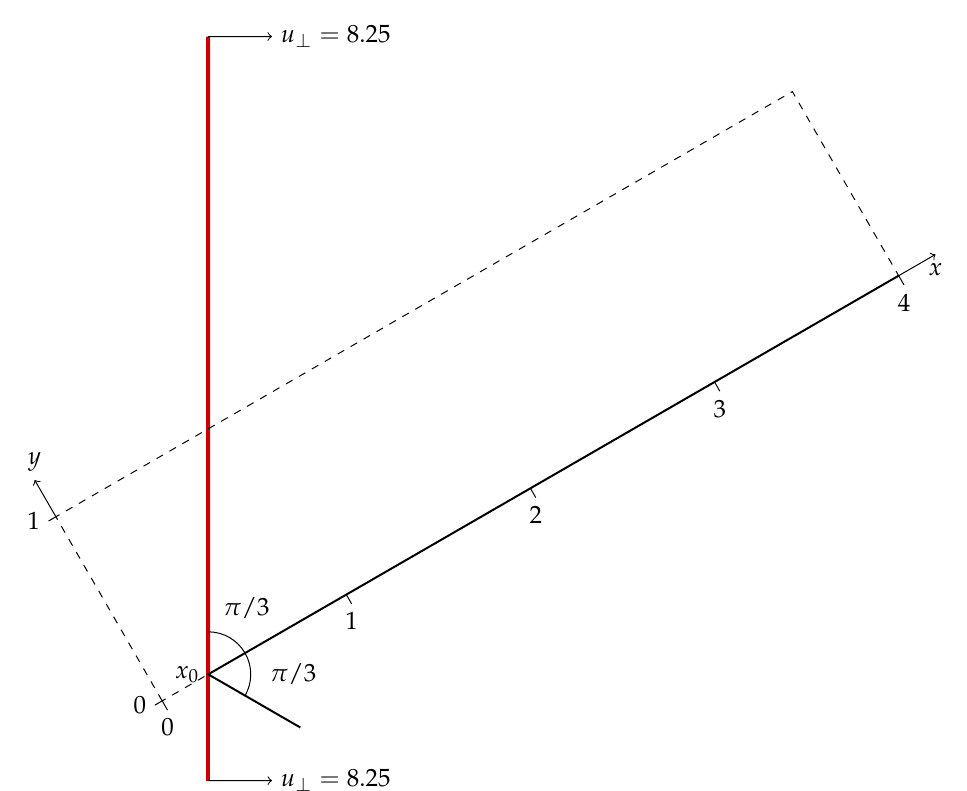
Figure 19. A schematic diagram of Problem 6. The rectangle bounded by four dashed lines and a solid line is the computational domain. The thick red line represents the initial shock wave, which is at an angle of π /3 relative to the x -axis.